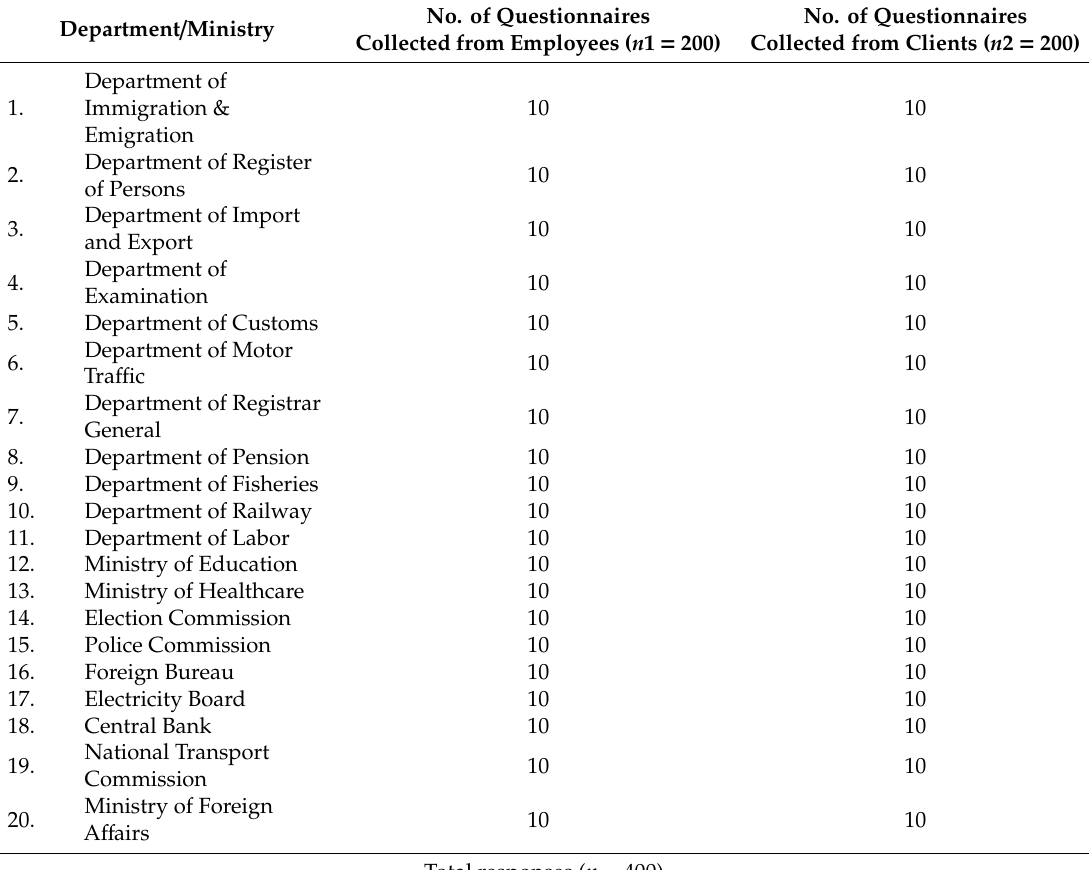
Table 2. Departments and ministries